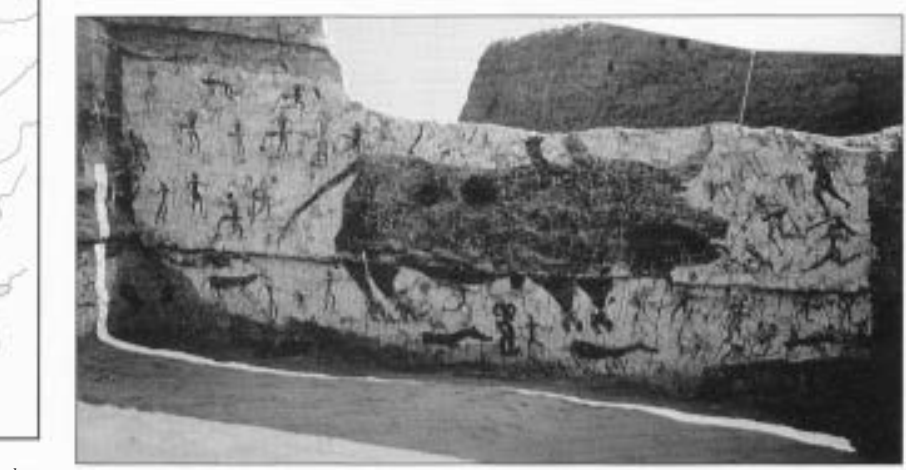
Ill discovered in the 1960s; it shows a